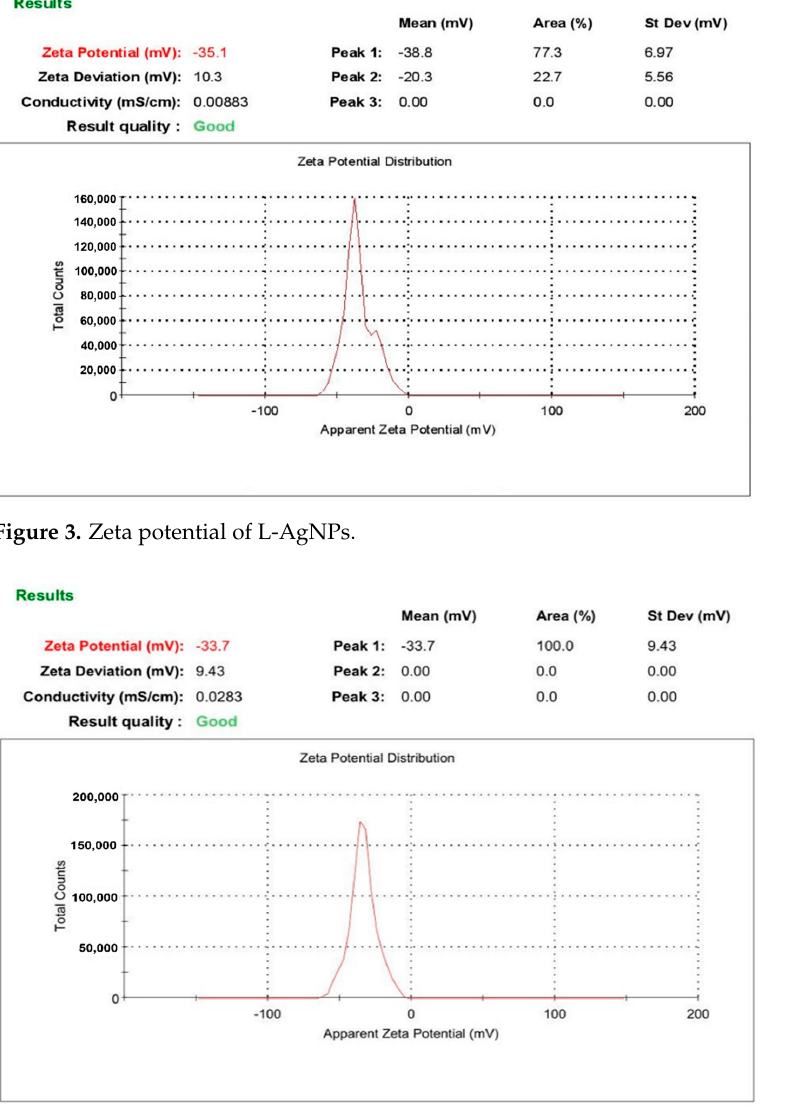
Figure 4. Zeta potential of R-AgNPs.